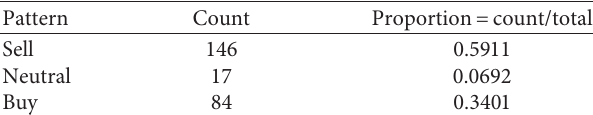
Table 4: Single-variable classification of pattern of NIFTY